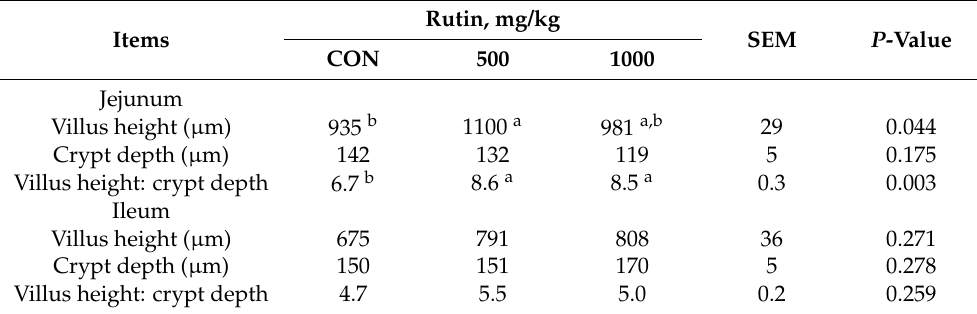
Table 3. Effect of rutin on the intestinal morphology of aged laying hens.